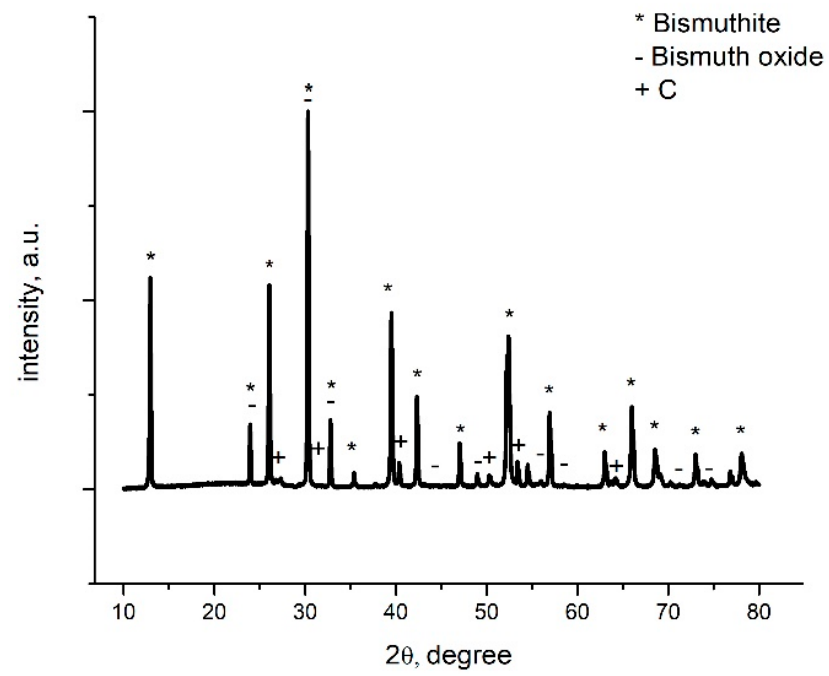
Figure 2. X-ray di ff raction spectrum recorded for sample BCb/CB. Figure 2. X-ray diffraction spectrum recorded for sample